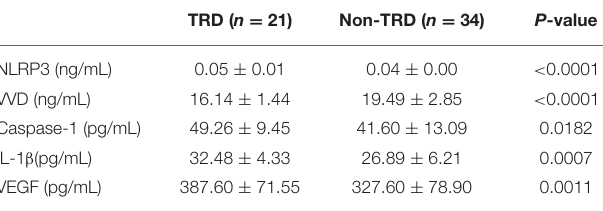
TABLE 2 | Level of inflammatory factor and vitreous 25 (OH) D in PDR patients with or without tractional retinal detachment. TRD ( n = 21) Non-TRD ( n = 34) P -value NLRP3